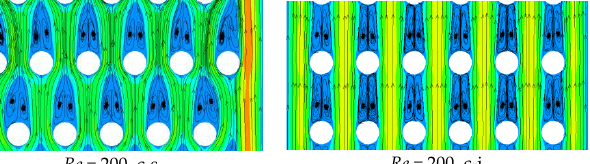
Figure 4. Velocity contour and streamline distribution in four types of micro-pin-fin arrays at different Re .